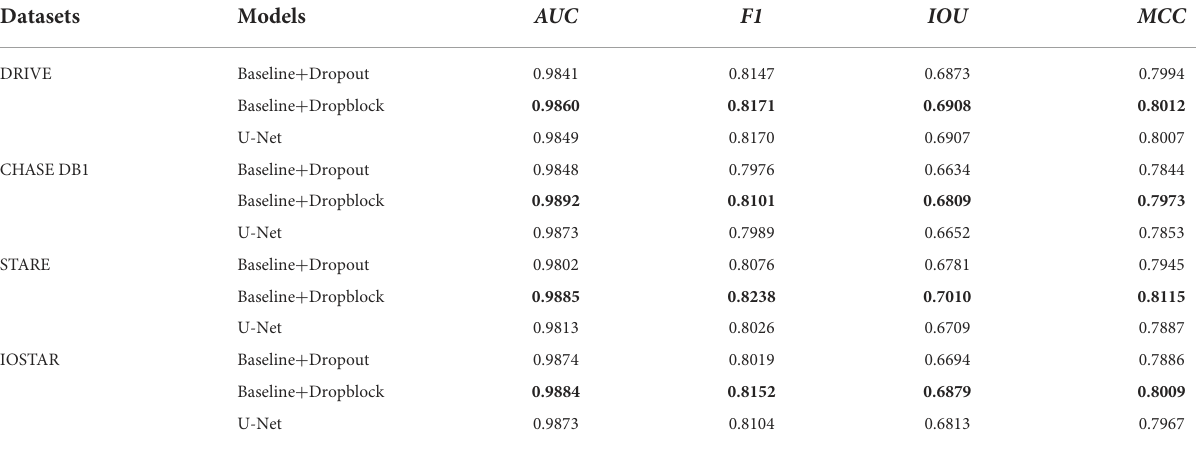
TABLE 3 Comparative experiments of Dropblock and Dropout on four datasets.